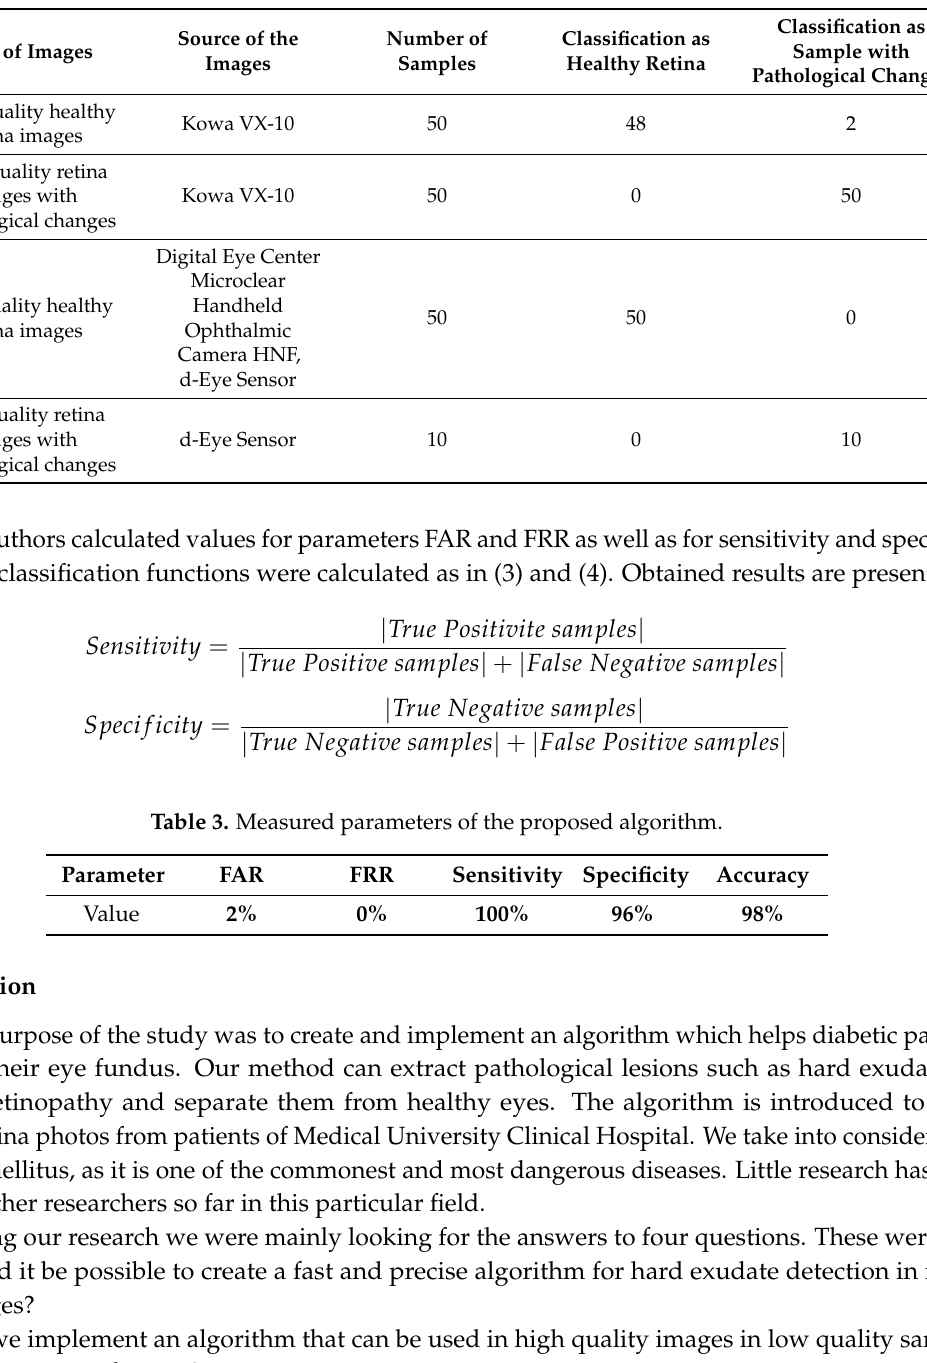
Table 2. The summary of the conducted experiments.